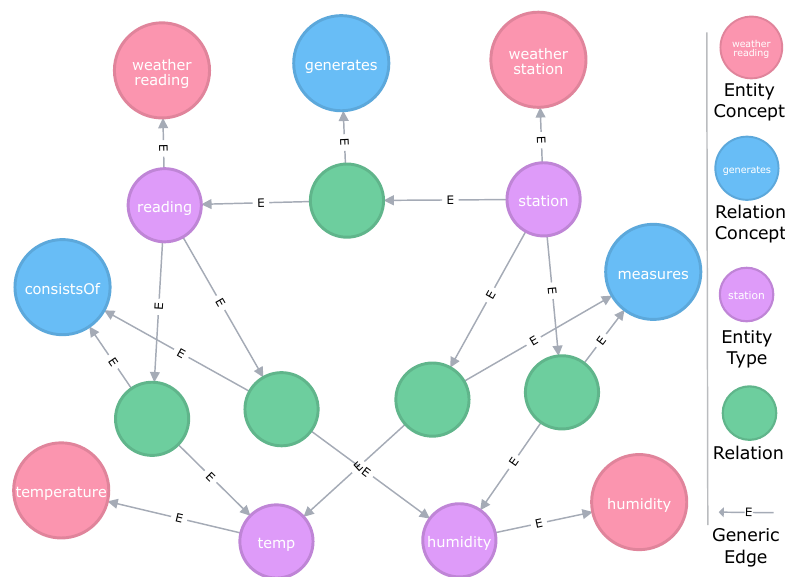
Figure 9. Partial representation of the semantic model shown in Figure 7 in the Neo4J database. The semantic model node is hidden for clarity but is connected to all Entity Types and Relations.